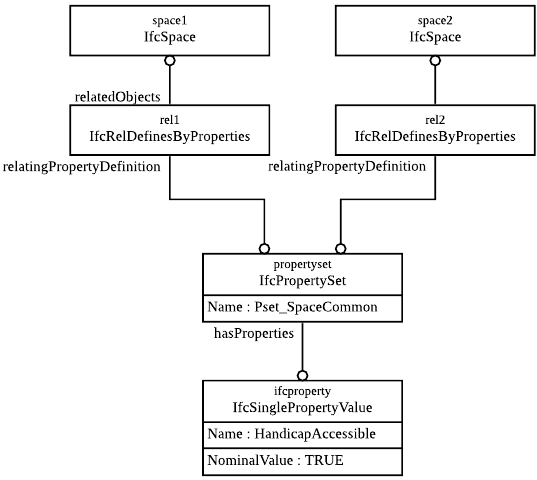
Figure 1. An instance of an IfcPropertySet node referenced by multiple entities in the IFC object graph.